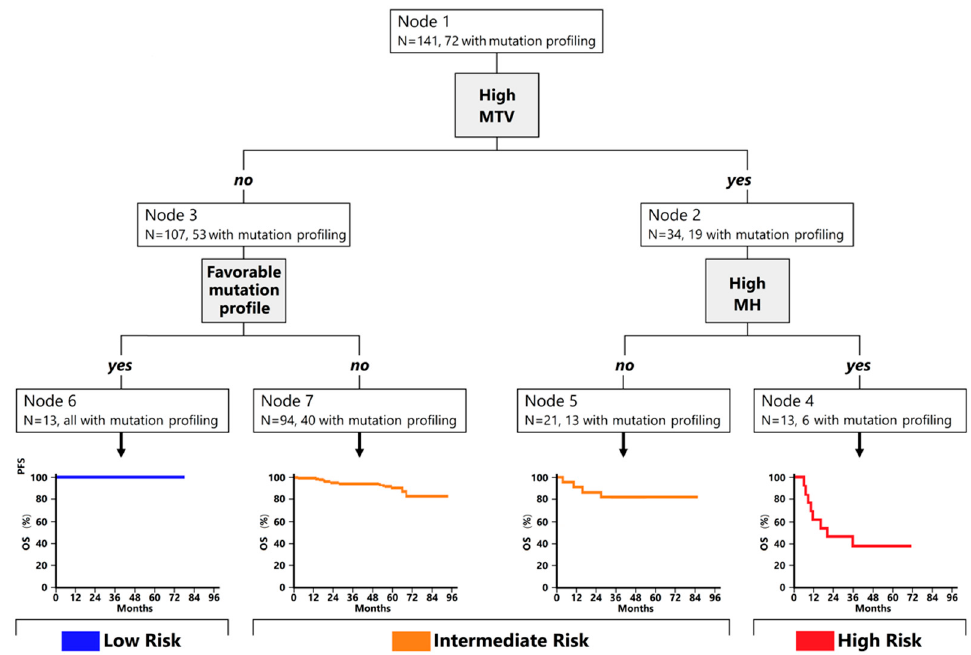
Figure 4. Classification tree analysis for overall survival prediction. Node 1: A total of 141 patients were included for the current analysis. Patients with high MTV were sorted in node 2 (N = 34). Node 2 was then sorted based on MH. Patients with MTV and MH high were clustered into node 4 (N = 13), while patients with MTV high and MH low were clustered in node 5 (N = 21). Patients with low MTV (node 3; N = 107) were then evaluated for the presence of a known favorable mutational profile. Patients with favorable mutational profiles and low MTV were classified in node 6 (N = 13). Patients with low MTV and without a known favorable mutational profile constituted node 7 (N = 94). Node 4 was defined as high-risk group, while node 6 was defined as low-risk group. Nodes 5 and 7 were then merged in a single group, referred to as intermediate-risk group.